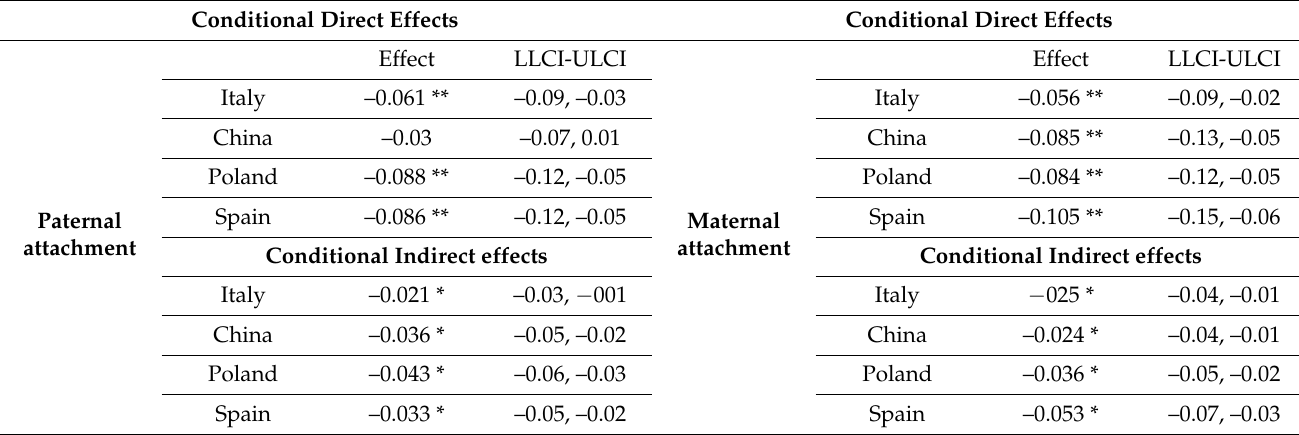
Table 3. Conditional direct and indirect effects at all levels of the